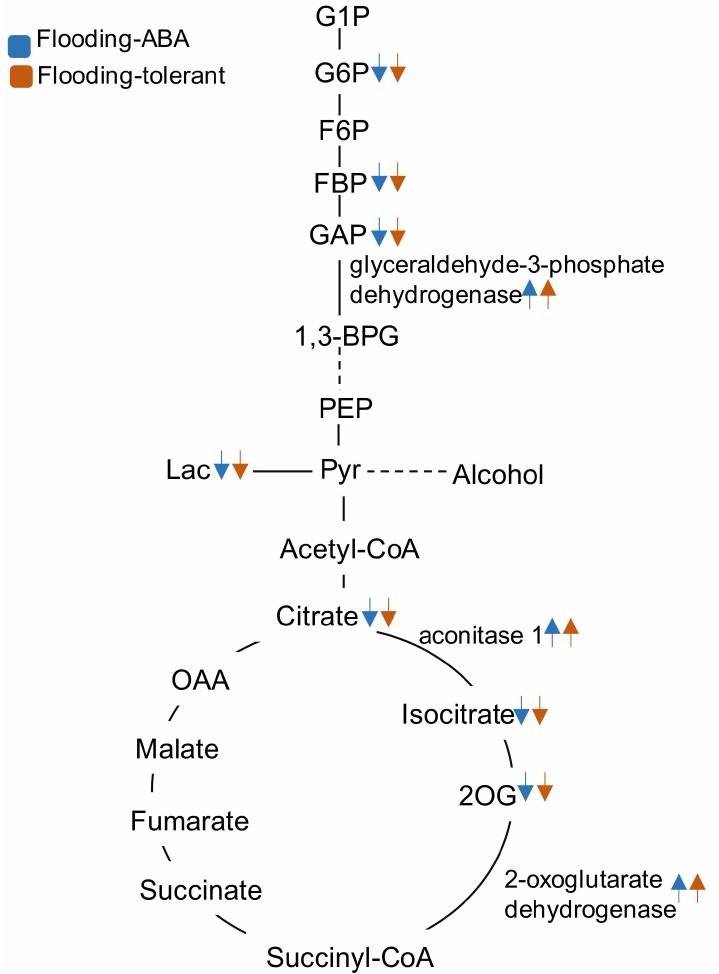
Figure 8. Schematic summary of major physiological processes in soybean roots under flooding conditions. On the basis of proteomic data, glycolysis, fermentation, and tricarboxylic acid cycle were highlighted as the major metabolisms affected in soybean roots under flooding. Aconitase 1,2-oxoglutarate dehydrogenase, and glyceraldehyde-3-phosphate dehydrogenase configured the candidates for flood-tolerance mechanisms. Metabolic simulation was conducted by concurrent modification of V max values of these three enzymes. Blue and orange colors present flooded soybean with ABA treatment and flood-tolerant plant, respectively. Protein abundance of aconitase 1,2-oxoglutarate dehydrogenase, and glyceraldehyde-3-phosphate dehydrogenase and metabolite accumulation predicated by metabolic simulation were presented in the ABA-treated soybean and flood-tolerant plant. Upward and downward arrows indicate increase and decrease, respectively, in protein abundance or metabolite accumulation in ABA-treated soybean and flood-tolerant plant compared to wide-type soybean under flooding. The abbreviations of metabolites are the same as described in the legend of Figure